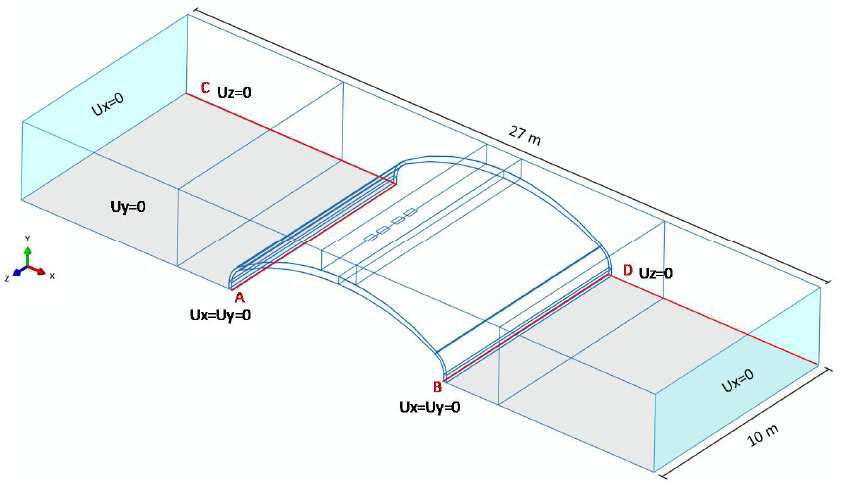
Figure 11. Boundary conditions considered in the FE model.